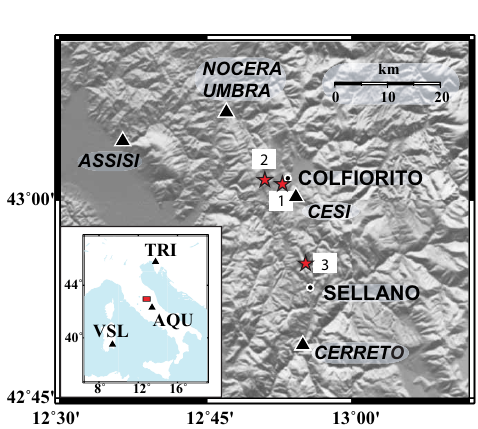
Fig. 1. The epicentres (red stars) of three largest events in the Umbria-Marche (1997-1998) sequence. Strong-motion stations are indicated by black trian- gles. The inset shows the area in the figure (red rec- tangle) and the location of broad-band MedNet sta- tions used in UMI studies (black